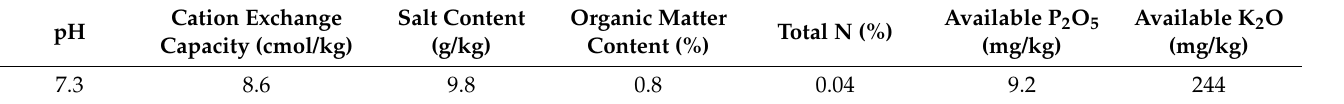
Table 2. Soil fertility